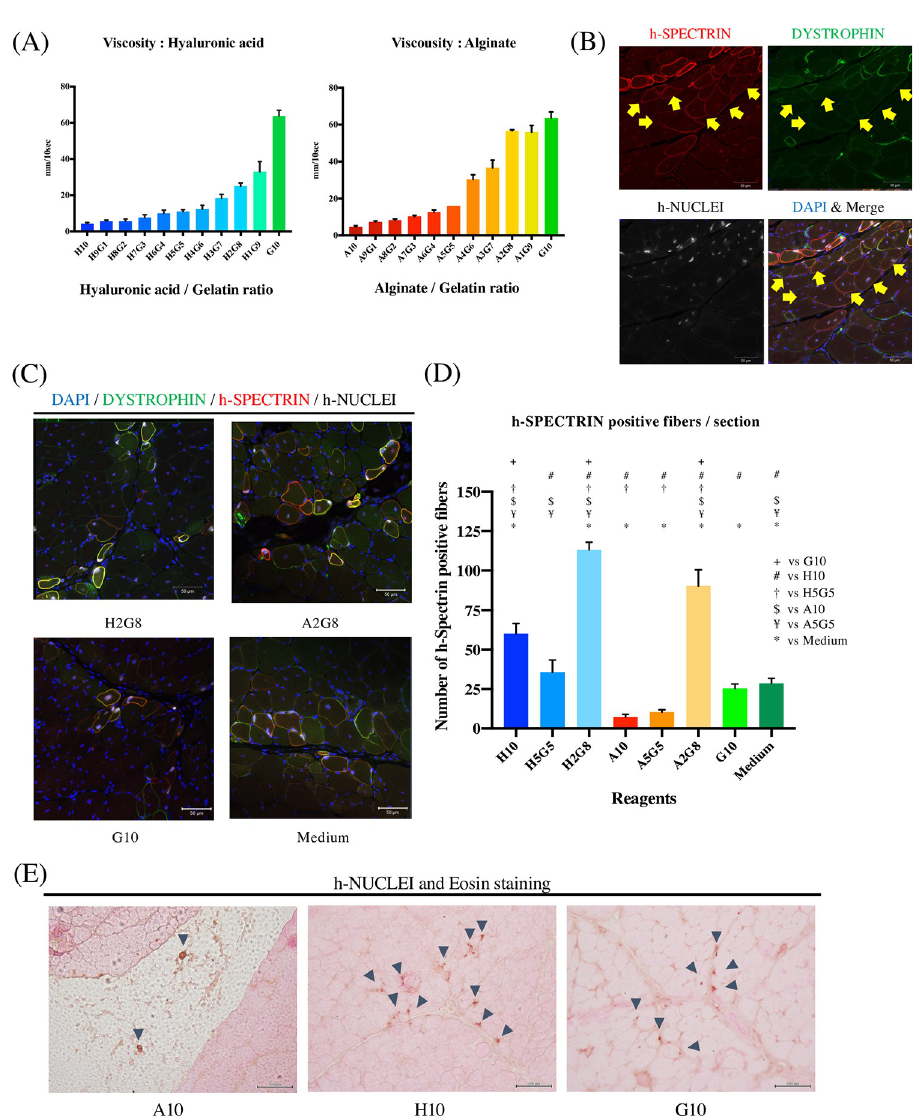
Fig 3. Injectable mixed polymer solution improves engraftment efficiency in the TA. (A) Velocities of mixed polymer solutions along a tilted glass. Data shown are from three independent experiments. (B) Immunohistochemistry staining 2 weeks after Hu5/KD3 transplantation into the TA. Sections were stained with anti- DYSTROPHIN antibody (green), anti-h-SPECTRIN antibody (red) and anti-h-NUCLEI antibody (white). Nuclei were stained with DAPI (blue). Scale bars, 50 μ m. Yellow arrowheads show the DYSTROPHIN signal was weaker than the signal in myofibers. (C) Immunohistochemistry staining 2 weeks after Hu5/KD3 transplantation into the TA. Sections were stained with anti-DYSTROPHIN antibody (green), anti-h-SPECTRIN antibody (red) and anti-h- NUCLEI antibody (white). Nuclei were stained with DAPI (blue). Scale bars, 50 μ m. (D) Quantification of h- SPECTRIN positive fibers derived from the engrafted cells. Data show the mean ± SEM (ANOVA with Tukey’s multiple comparison test). Each mark above the bars indicates a statistically significant difference. Data shown are from three independent experiments. The number of sections in each analysis is 44 or 45. (E) Immunohistochemistry and eosin staining. Engrafted cells were stained with h-NUCLEI (blown). Arrowheads show engrafted cells. Scale bars, 100 μ m. For the mixed polymer solution names, H = hyaluronic acid, A = alginate, G = gelatin, and numbers indicate the ratios of the material in the mixed polymer